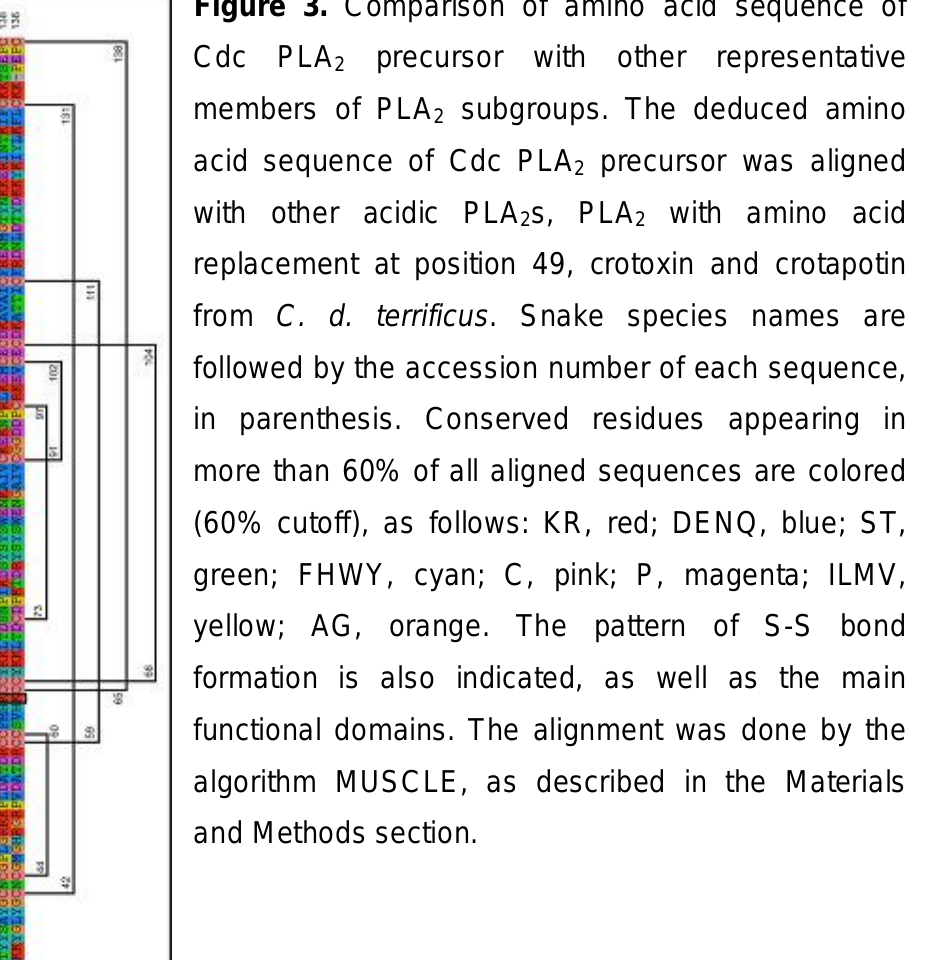
Figure 3. Comparison of amino acid sequence of Cdc PLA precursor with other representative 2 members of PLA subgroups. The deduced amino 2 precursor was aligned acid sequence of Cdc PLA 2 with other acidic PLA s, PLA with amino acid 2 2 replacement at position 49, crotoxin and crotapotin from C. d. terrificus . Snake species names are followed by the accession number of each sequence, in parenthesis. Conserved residues appearing in more than 60% of all aligned sequences are colored (60% cutoff), as follows: KR, red; DENQ, blue; ST, green; FHWY, cyan; C, pink; P, magenta; ILMV, yellow; AG, orange. The pattern of S-S bond formation is also indicated, as well as the main functional domains. The alignment was done by the algorithm MUSCLE, as described in the Materials and Methods